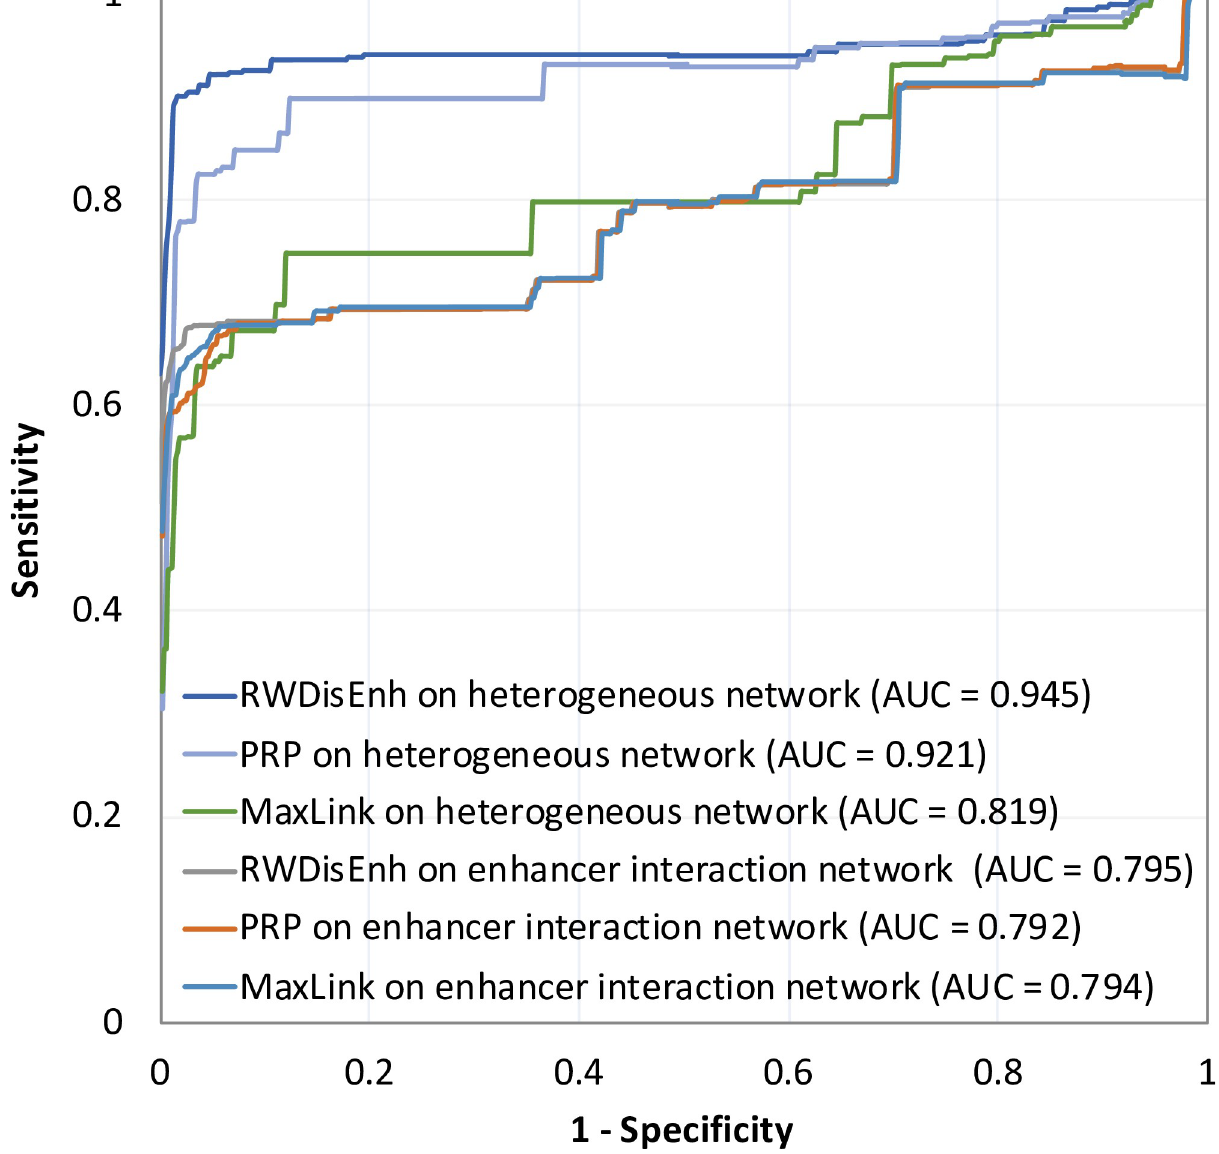
Fig 4. Performance comparison between RWDisEnh and other methods. The best settings of RWDisEnh and PRP were